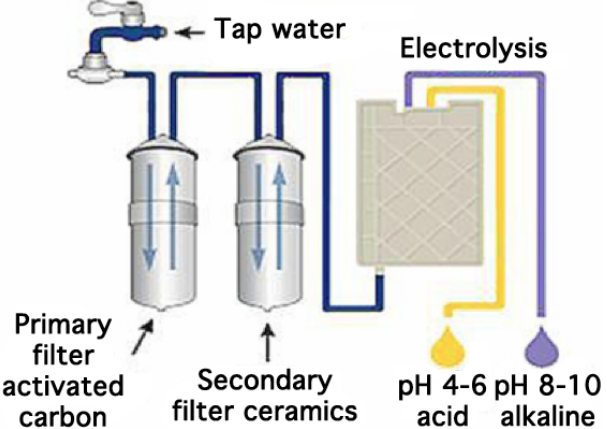
Figure 2. General overview of a commercial electrolyzed water